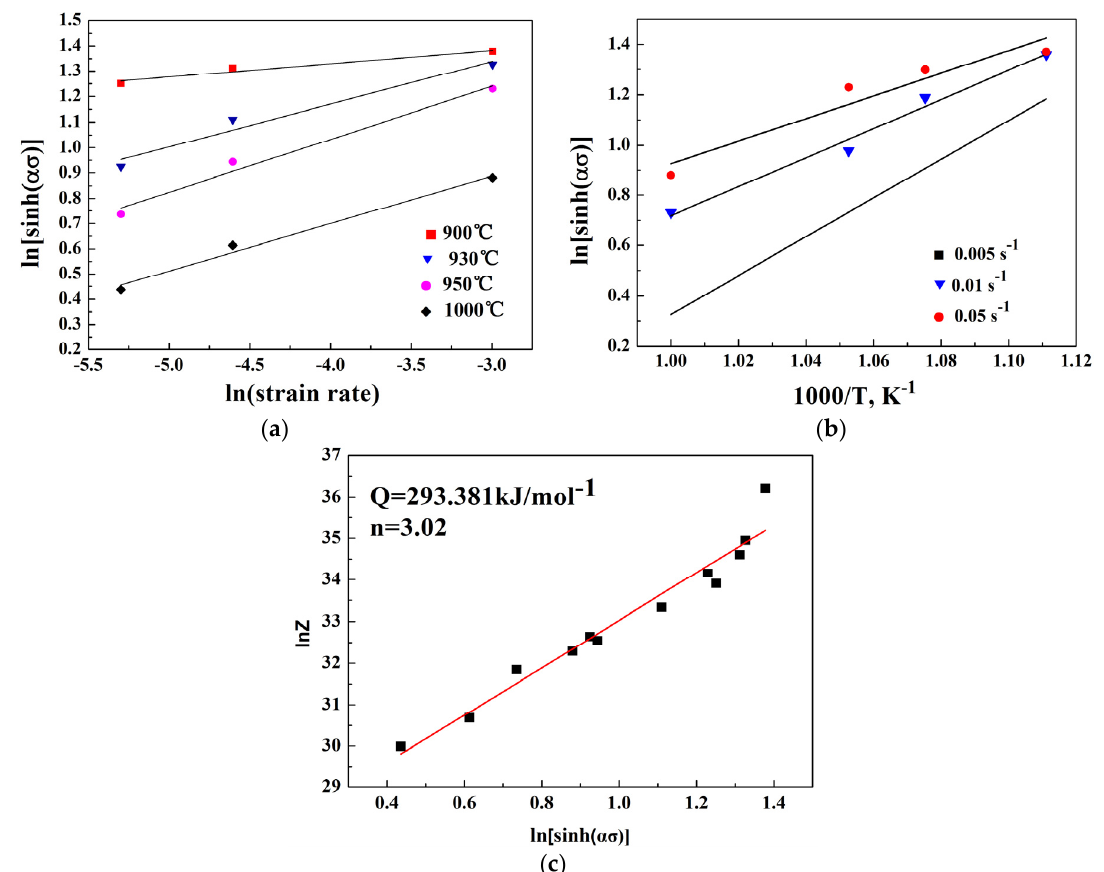
Figure 3. ( a ) Variation of flow stress with strain rate at different temperatures. ( b ) Arrhenius plot showing the variation of flow stress with temperature at different strain rates and ( c ) linear variation of lnZ with ln[sinh( ασ )].